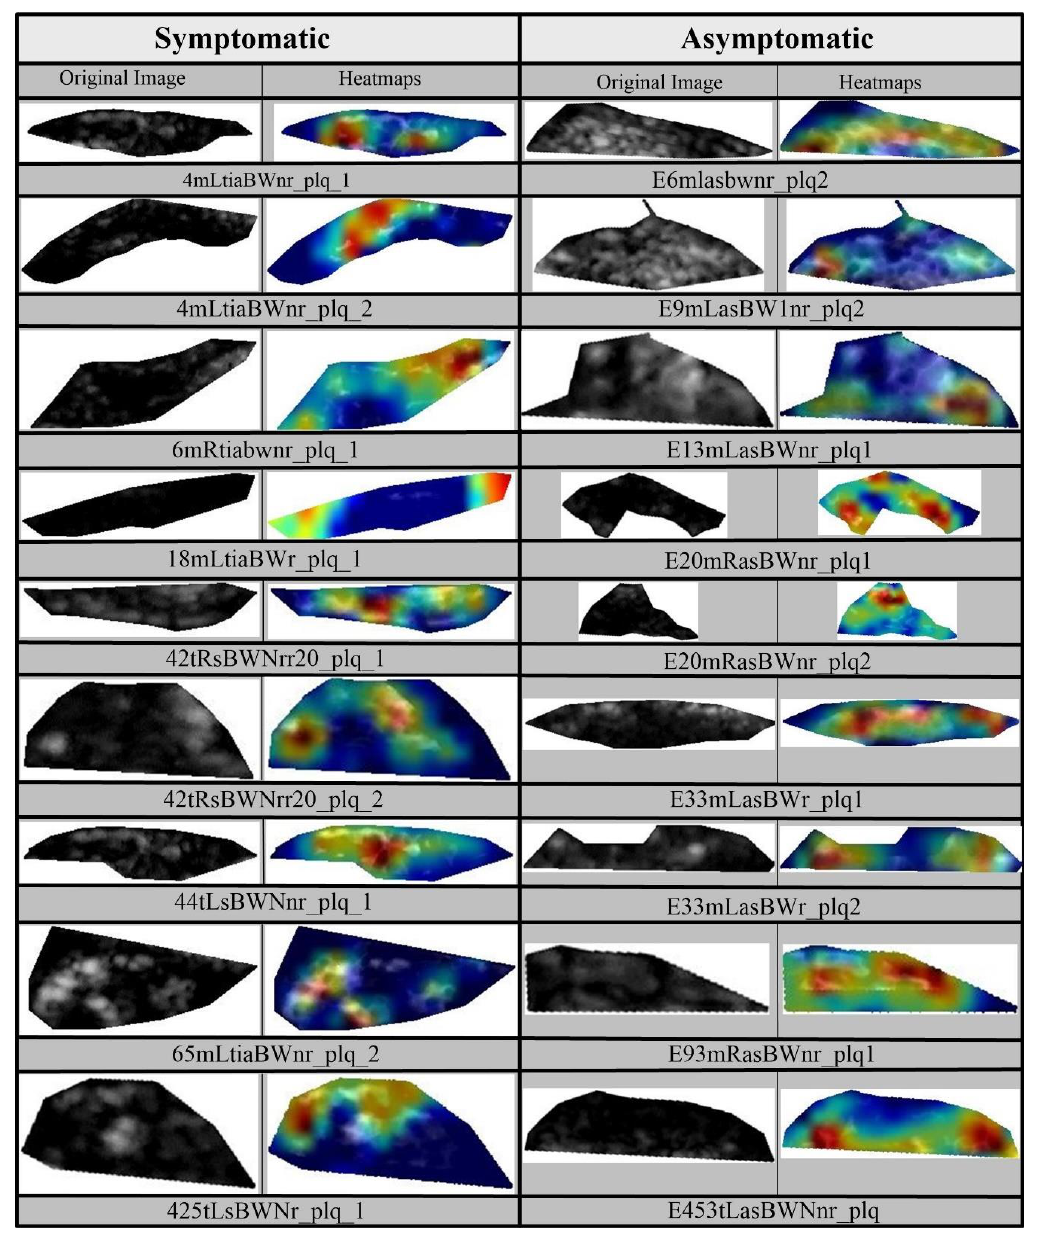
Figure 16. Heat maps of the symptomatic plaque ( left ) and asymptomatic plaque ( right ). Table 6. Euclidean distance between biomarker